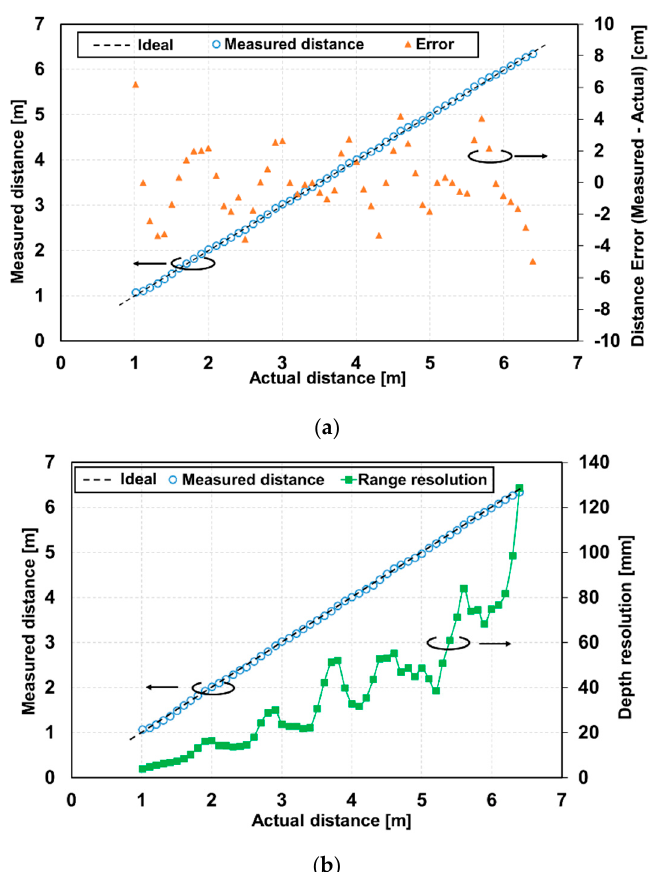
Figure 10. Measured distance versus real distance with modulation timing being the same accumulation time: ( a ) non-linearity error and measured distance, and ( b ) depth resolution and measured distance.